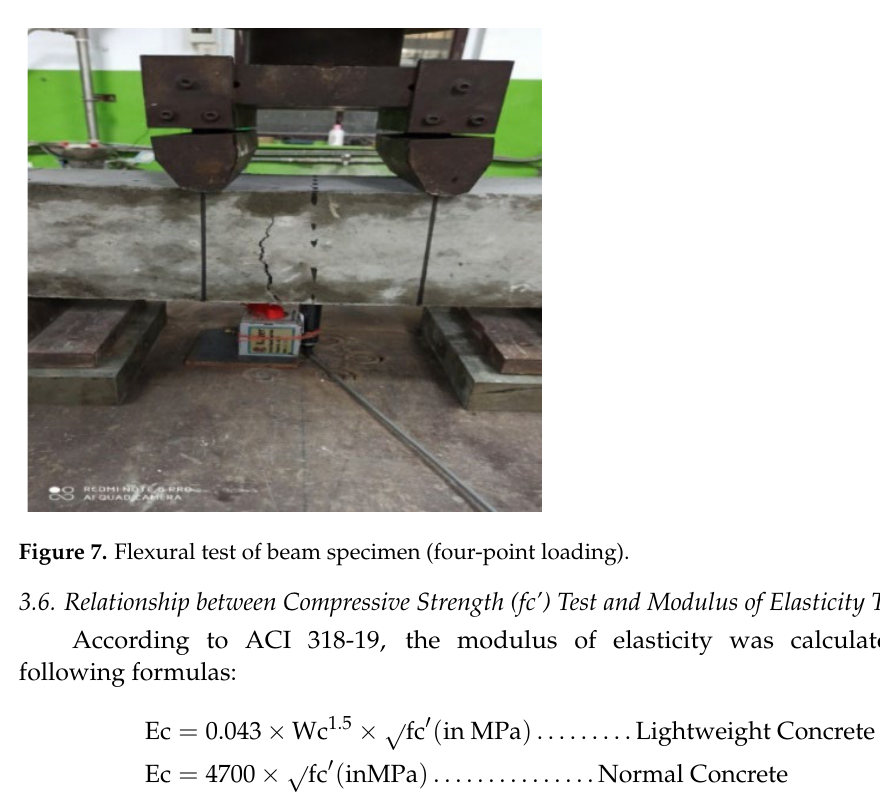
Figure 6. Split tensile test of the cylinder.